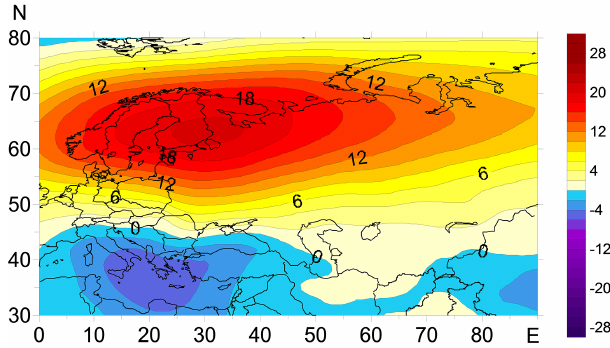
Figure 23. Composite of SLP anomaly corresponding to the second weather regime of storm days